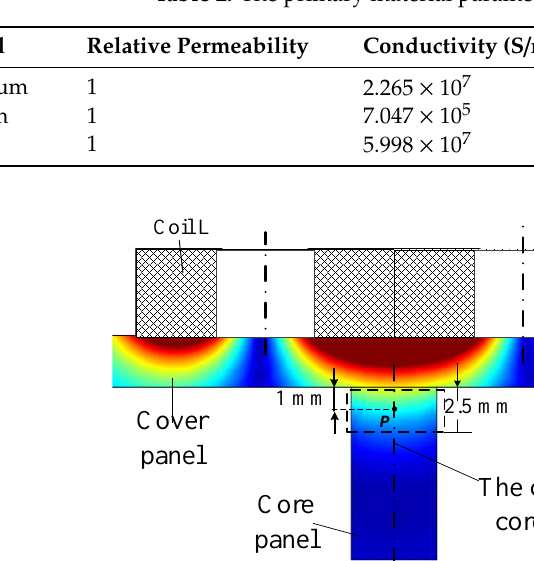
Table 2. The primary material parameters for simulation.